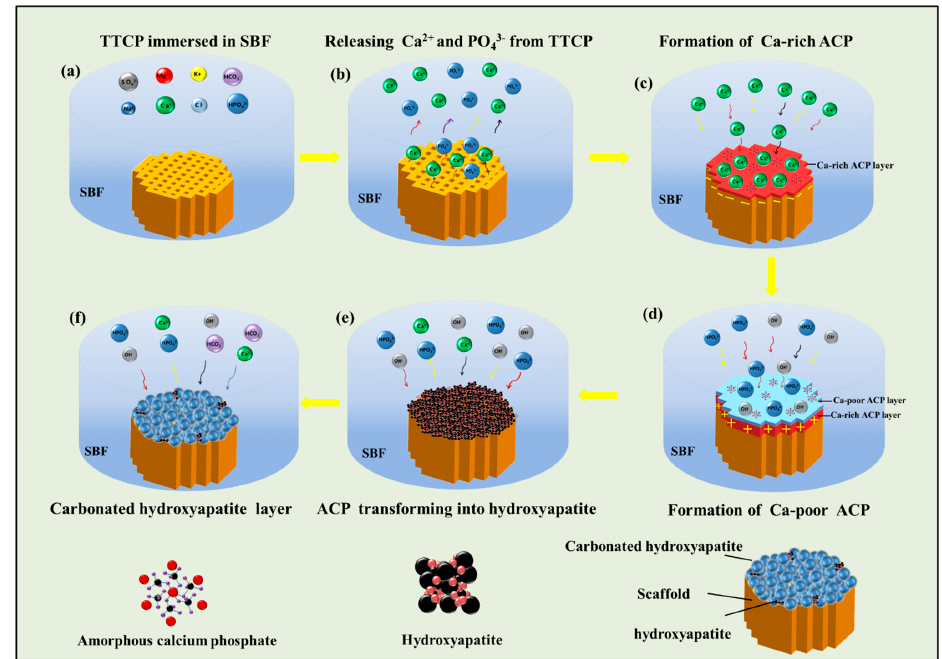
Figure 8. Study on the mechanism of the formation of apatite: ( a ) TTCP immersed in SBF ( b ) dissolution of TTCP, ( c ) formation of Ca-rich ACP, ( d ) formation of Ca-poor ACP, ( e ) increasing formation of apatite on the surface of the TTCP sca ff olds, and ( f ) hydroxyapatite containing carbonate in its